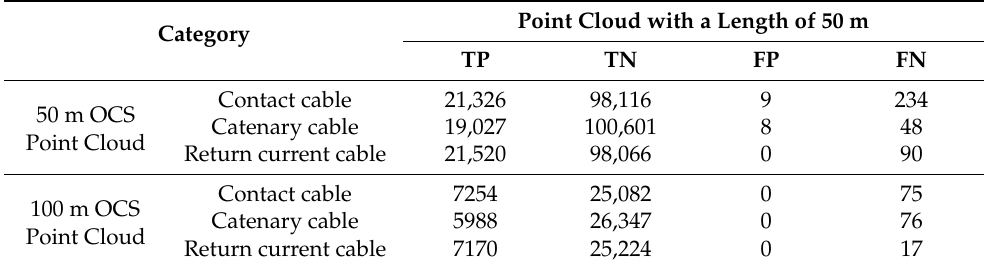
Table 2. TP, TN, FP, and FN values in classification results with the algorithm proposed in this article.